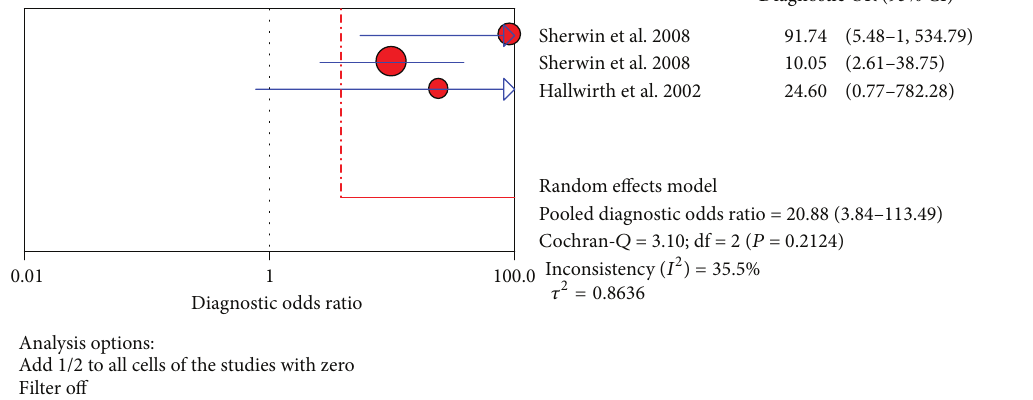
It is well known that an excellent marker should have high sensitivity and specificity. In our meta-analysis, the TNF- 𝛼 tests’ sensitivity is 0.66 for the diagnosis of early- onset neonatal sepsis, and the specificity is 0.46 and the 𝑄 ∗ is 0.74. At the late-onset neonatal sepsis, the TNF- 𝛼